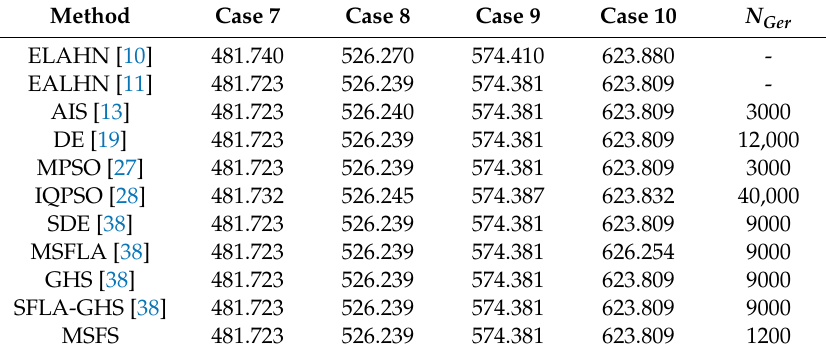
Table 9. Comparison of minimum cost ($ / h) for cases 7, 8, 9 and